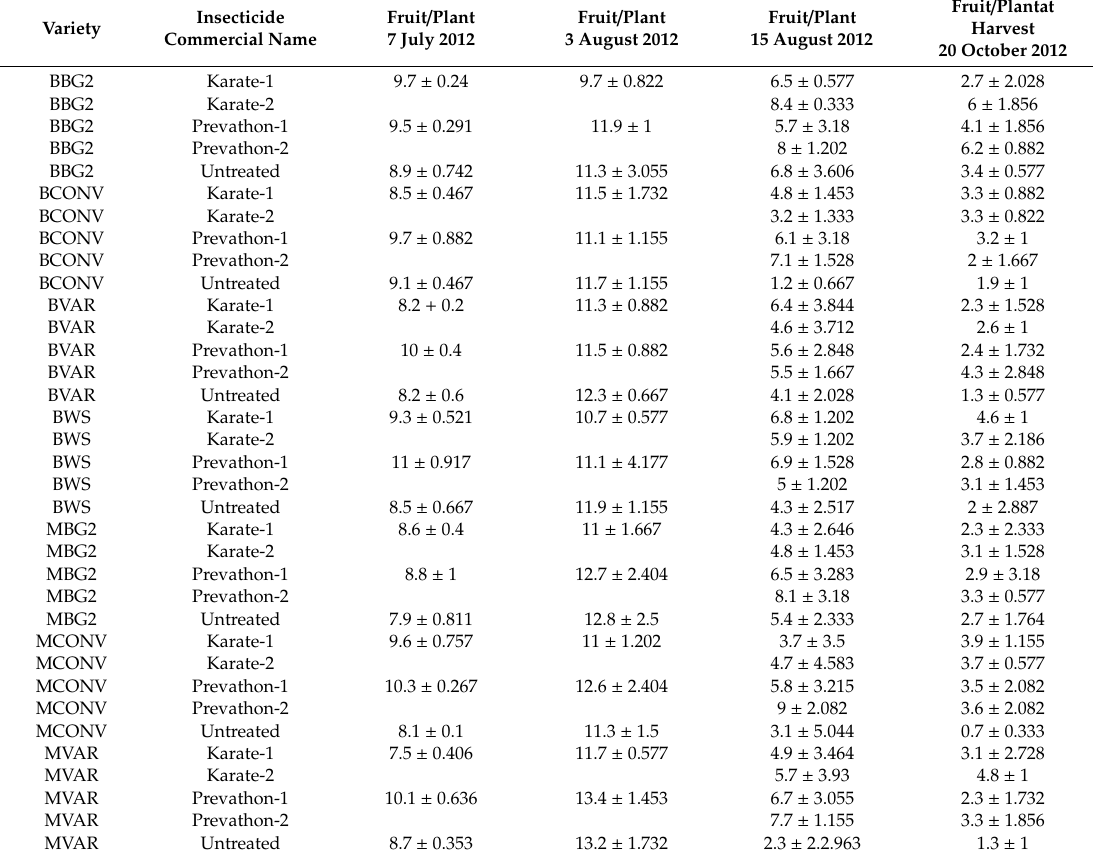
Table 8. Mean ± SEM number 1st position fruit per plant on three within-season sample dates and at harvest in